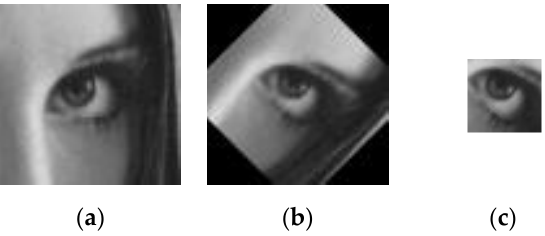
Figure 7. An example of scale and rotation normalization. ( a ) is the original feature region (70 × 70 pixels), with a scale representation of 16.6 and orientation representation of 45°. The normalized feature region based on the estimated scale and orientation representations is shown in ( b ). ( c ) is the FRI of 30 × 30 pixels extracted from the normalized feature region for SYBA